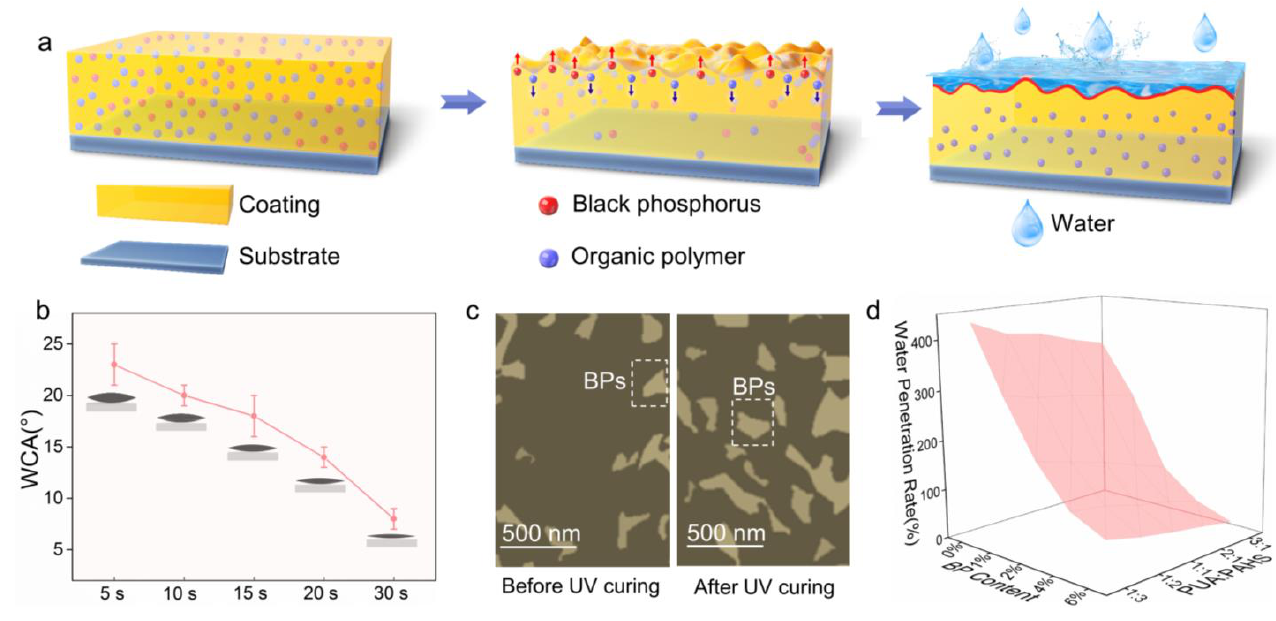
Figure 5. ( a ) Schematic diagram of long-term antifogging mechanism of PUA/PAHS/BPs HN. ( b ) WCA of PUA/PAHS/BPs HN with different UV curing times. ( c ) Microscopic photographs of PUA/PAHS/BPs HN before and after UV curing. ( d ) Water penetration rate of PUA/PAHS/BPs HN with different BPs content and mass ratio of PUA to PAHS.